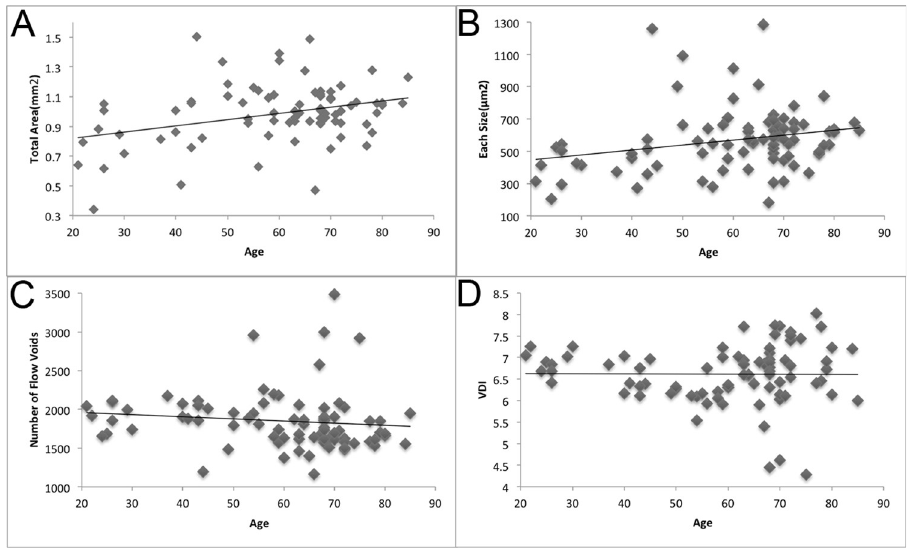
600.1 ± 179.0 μ m 2 , respectively, in the age group � 60 years. The age-related gains in the mean total area and size of flow voids were 4.20 × 10 − 3 mm 2 and 3.07 μ m 2 per year, respectively. The mean number of flow voids was 1851 ± 375. No significant correlation was observed between the number of flow voids and age (p = 0.290) (Fig 3). The mean VDI was 5.82 ± 0.49. No signif- icant correlation was observed between the VDI and age (p = 0.947) (Fig 3). Representative images from each age group are shown in Fig 4.